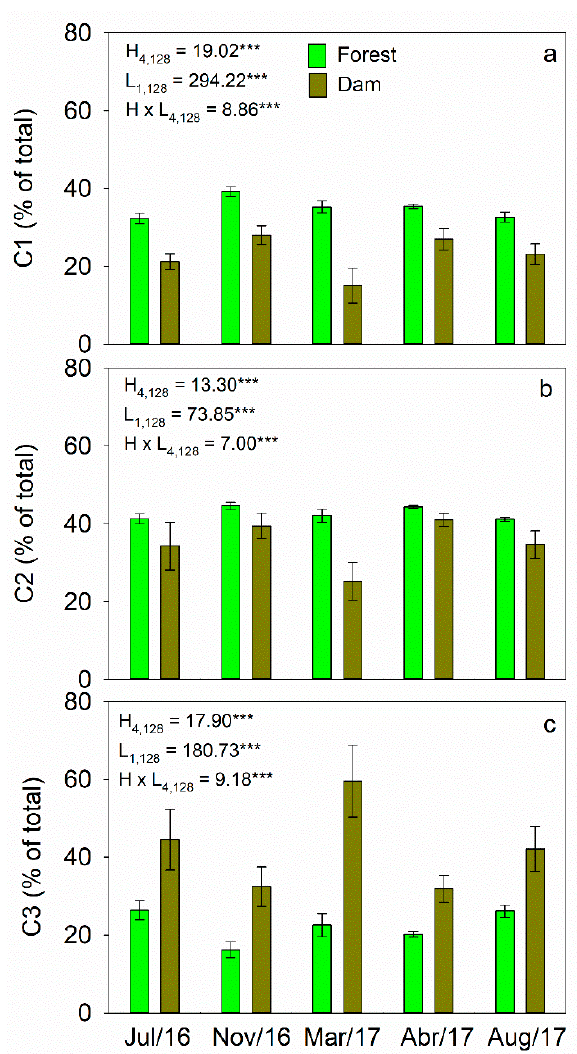
Figure 6. Mean (95% CI, n = 11 Dam; n = 15 Forest) at the research site, grouped by Dam and Forest catchments and hydrological month for percentages of the total fDOM for ( a ) C1, ( b ) C2, and ( c ) C3. The statistical results are expressed using the Tamhane test of non-presumed equal variances and the probability of type I error (P) to test with land cover (L) and hydrological month (H) as fixed effects. *** p < 0.001.